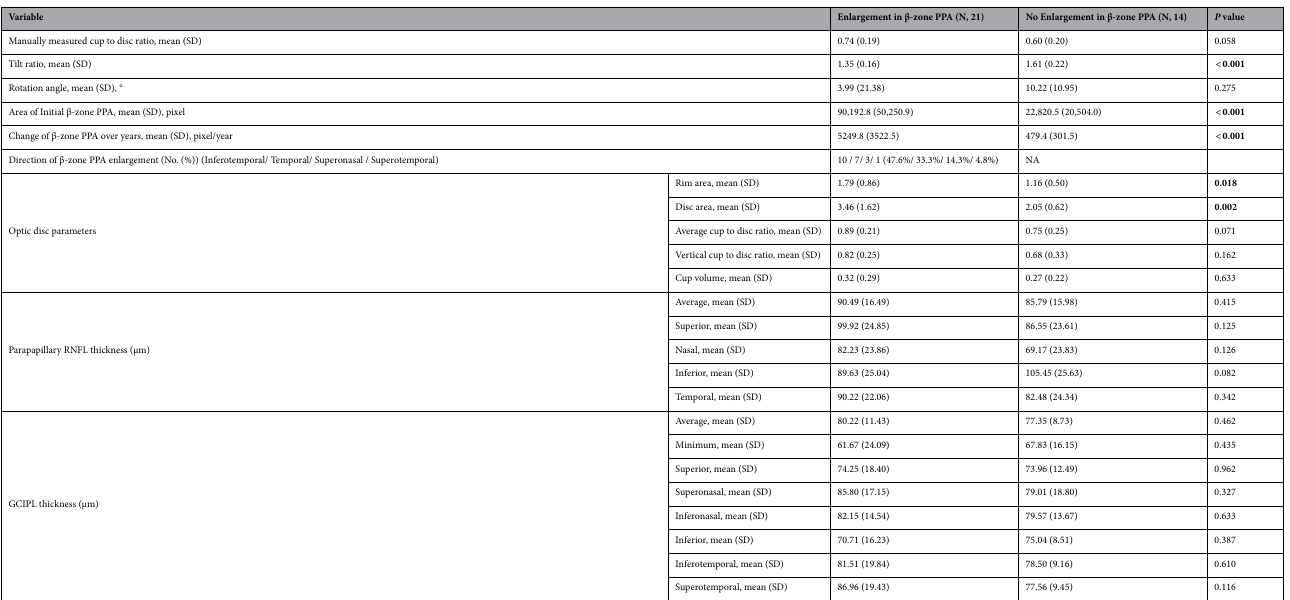
Table 7. Comparison of optic disc and optical coherence tomography parameters in eyes of the temporal visual field defect group in terms of presence of β-zone PPA progression. Progression of β-zone PPA was defined with a change of β-zone PPA area over 1000 pixel /year. PPA peripapillary atrophy, NA not available, RNFL retinal nerve fiber layer, GCIPL ganglion cell inner plexiform layer. Values obtained from optical coherence tomography was corrected with the Littmann’s formula. Student’s t test. Bold font indicates significant P values ( P < 0.05). a Bonferroni correction for multiple measurement comparison was applied, and a level of significance was set at 0.002